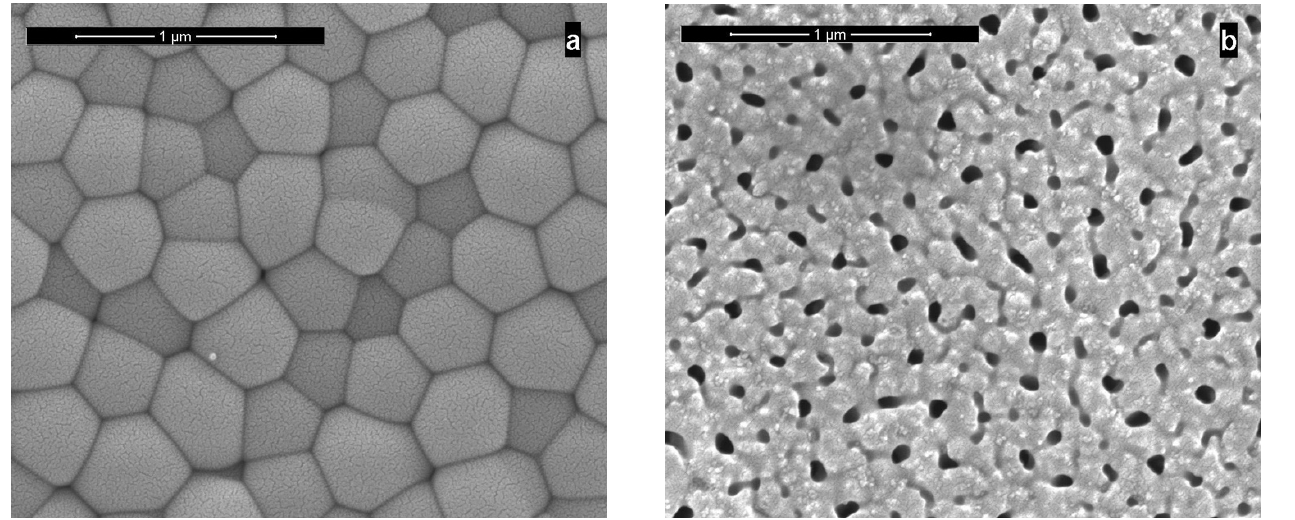
Figure 4. FESEM images of PAA formed at 160 V and 0 °C in 0.4 M H 3 PO 4 and 0.095 M Al(OH) 3 after passing 20 C cm − 2 : ( a ) inner and ( b ) outer surface. Table 1. Morphological features of PAA dependent on the electrolyte composition and passed electrical charge for aluminum anodization at 160 V and 0 °C.